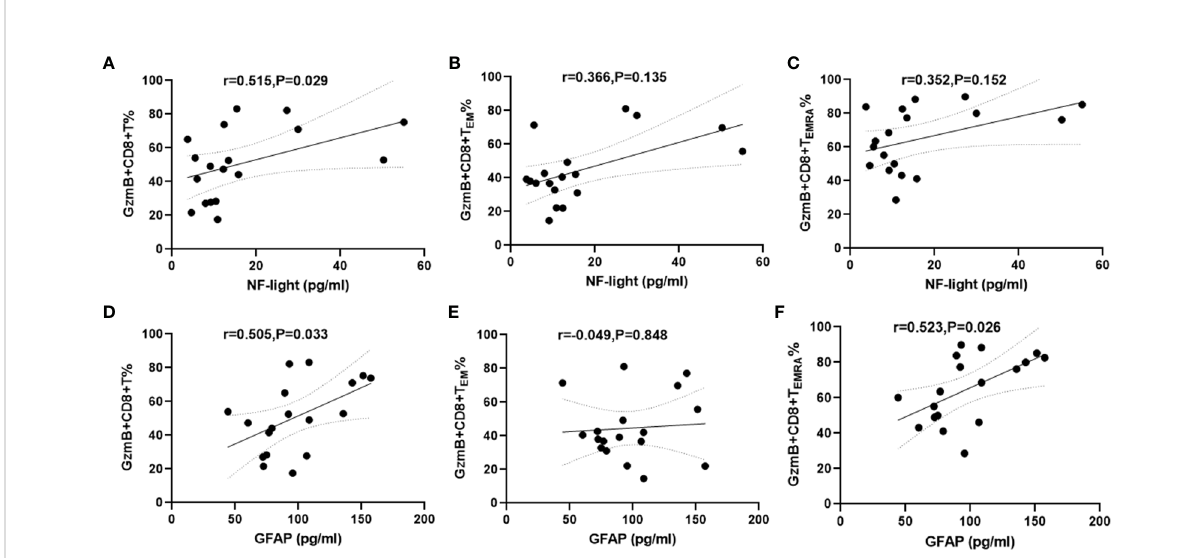
FIGURE 4 Positive correlation between proportions of GzmB+CD8+ T cells and serum NFL and GFAP levels in patients with NMOSD. (A – C) Association between the proportion of GzmB-expressing CD8+ T cells and serum NFL (n=18). (D – F) Association between the proportion of GzmB- expressing CD8+ T cells and serum GFAP (n=18) by spearman correlation analysis. GzmB, granzyme B; NMOSD, neuromyelitis optica spectrum disorder; NFL, neuro fi lament light; GFAP, glial fi brillary acidic